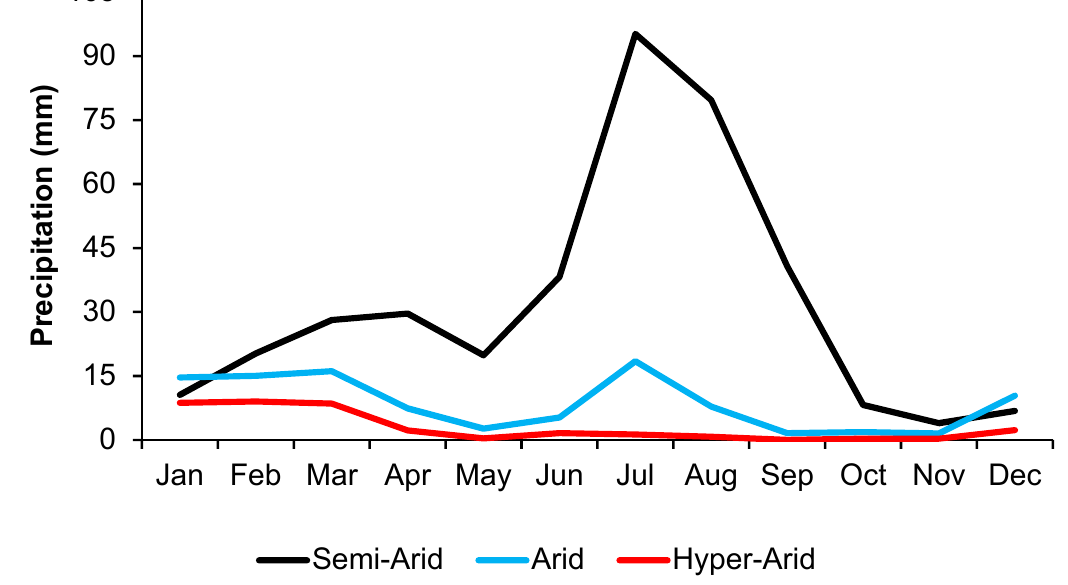
Figure 2. Monthly distribution of precipitation at semi-arid, arid, and hyper-arid regions. The monthly gridded data of GPCC, CRU, APHRODITE, and UDel with 0.5 o spatial resolution